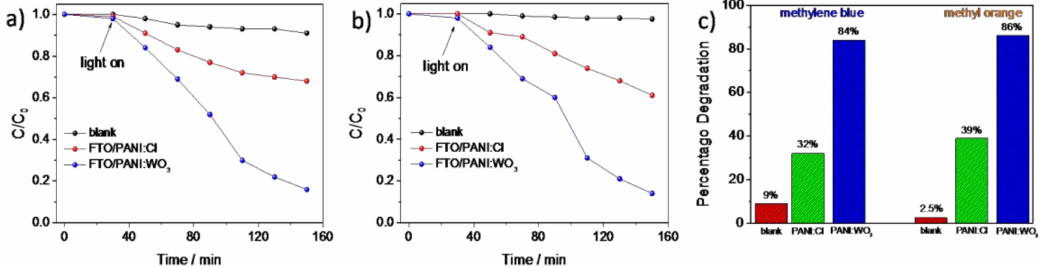
Figure 9. Comparison of the photocatalytic degradation of ( a ) MB and ( b ) MO in the presence ofPANI / Cl and PANI / WO 3 composite photocatalysts under sunlight irradiation and ( c ) diagram showing the results of